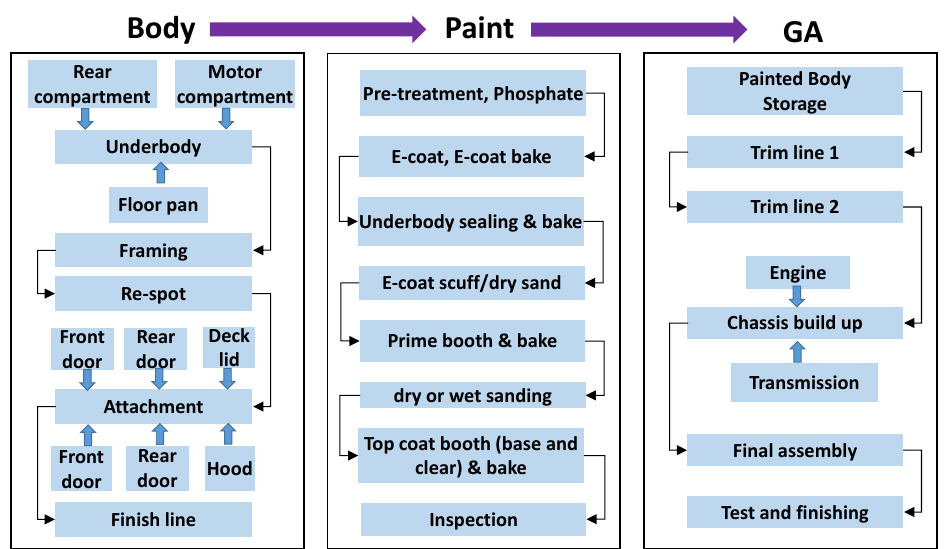
Figure 1. Main manufacturing processes in vehicle assembly